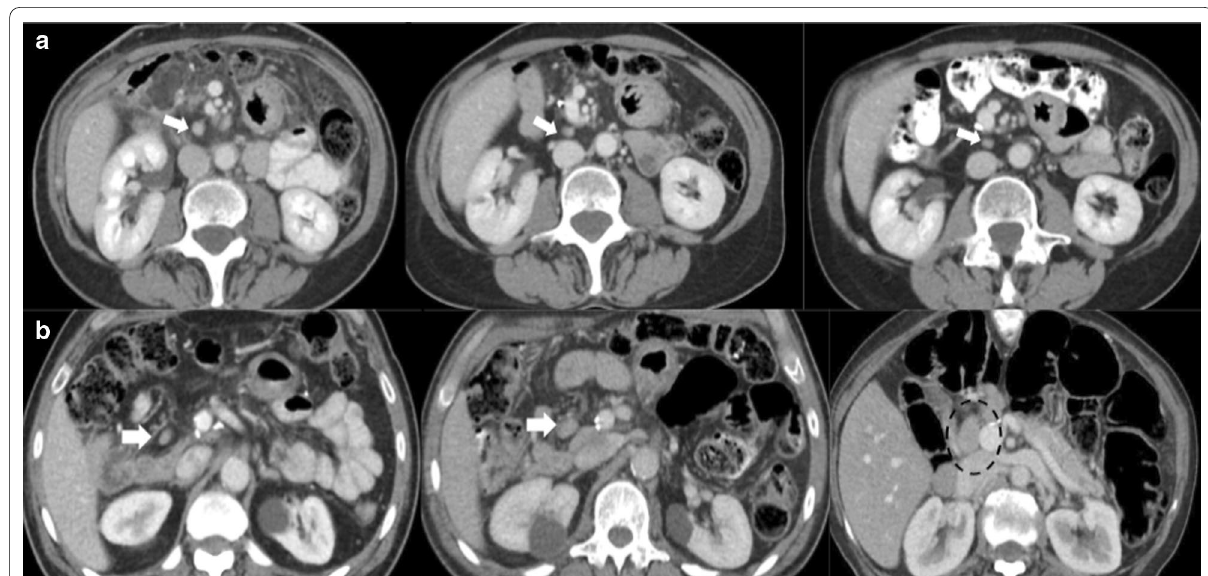
Fig. 8 Lymphadenopathy vs. Tumor recurrence. CT challenge. Two different patients ( a ) 63-year-old female patient with persisting lymph node along 2-year follow-up. Six months, one- and two-years CT scans, respectively. Note the decreasing size of the node over time (big arrow). Clinical and biological markers level stable. ( b ) 65-year-old male patient along annual CT scan controls. An increasing lymph node is seen during the follow-up (large arrow). Note the rounded shape appearance and the short axis size greater than 10 mm (dotted circle) after three years from surgery. Tumor recurrence was proven by biopsy in patient B